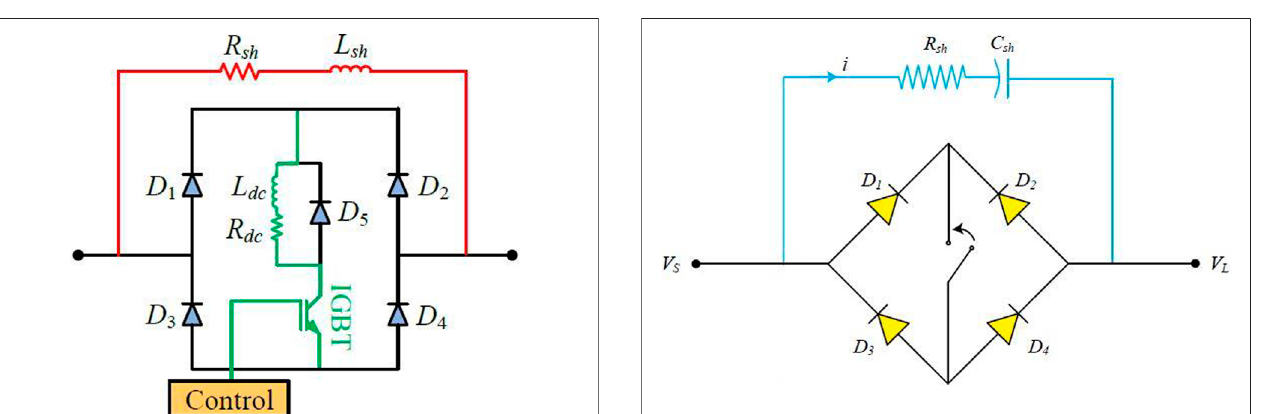
FIGURE 6 | On-state equivalent CBFCL in the PMSG wind turbine.